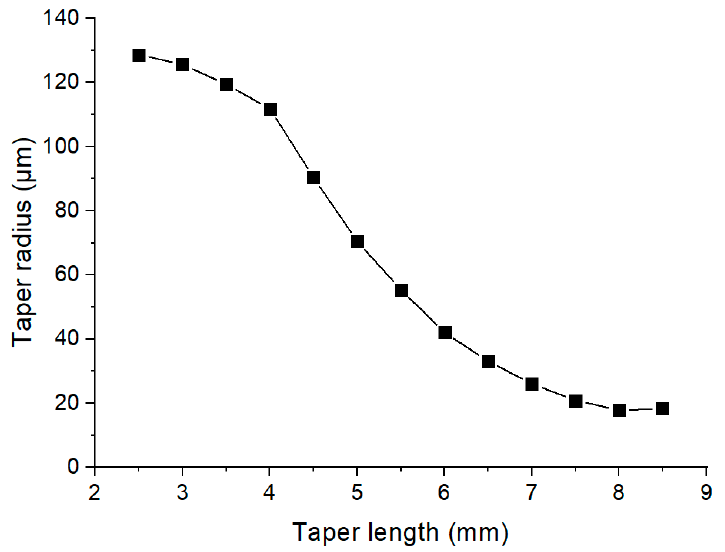
Figure 5. Typical taper profiles with radii 20 to 45 μ m.